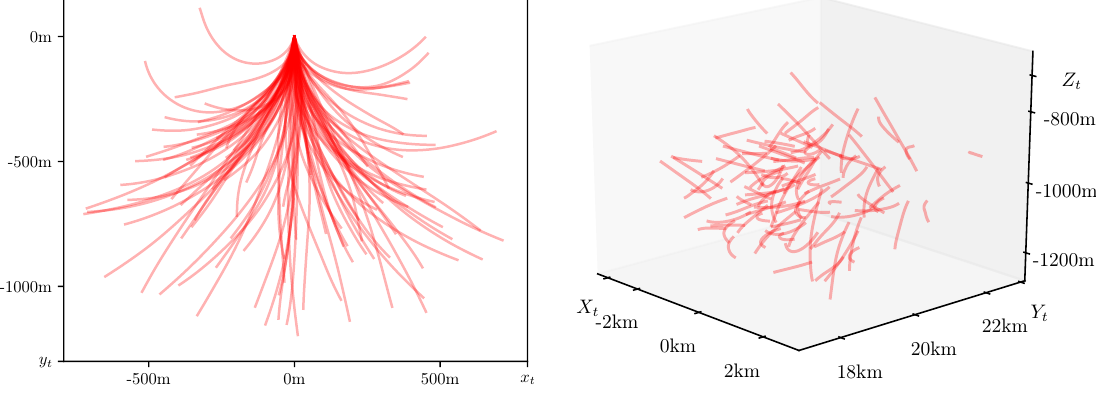
Figure 4. Sample paths in the target coordinate system 0 xyz ( left figure ) and in the observer coordinate system 0 XYZ ( right figure